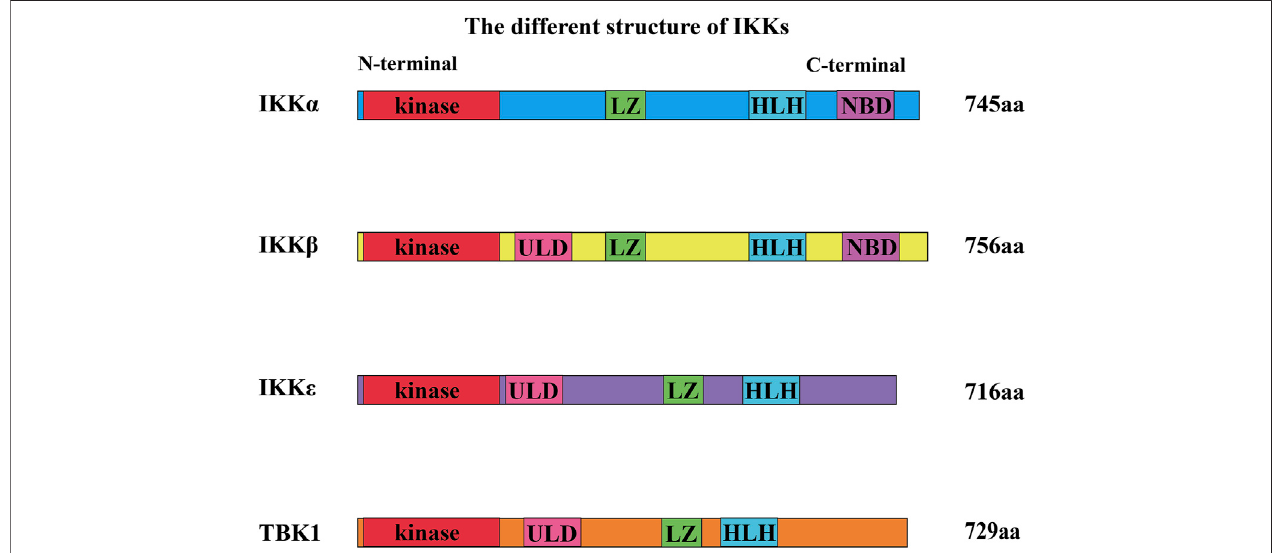
FIGURE2| DifferentstructuresofIKKs.TheN-terminalregionofIKKshasakinasedomain,allowingthemtotriggerthephosphorylationofdownstreammolecules. They also have a leucine zipper (LZ) and a helix – loop – helix (HLH). Ubiquitin-like domain (ULD) is only discovered in the structure of IKK β , TBK1, and IKK ε . Furthermore, IKK α and IKK β both have a domain called the NEMO-binding domain (NBD).